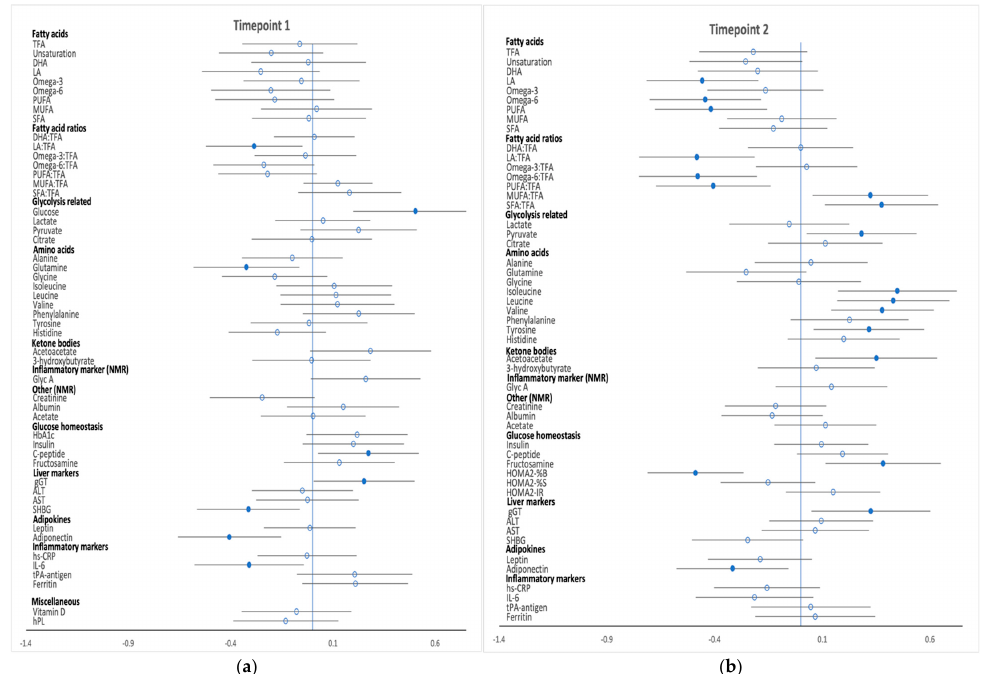
Figure 3. Differences in fatty acids, glycolysis-related metabolites, amino acids, ketone bodies and inflammatory and other markers between high-risk women who developed GDM and those who did not develop GDM at timepoints 1 ( a ) and timepoint 2 ( b ). Data points show the SD difference at baseline (timepoint 1) and at the time of OGTT (timepoint 2). Positive associations with GDM are shown to the right, negative associations are shown to the left. Closed blue circles represent FDR- corrected p values of < 0.05. DHA, docosahexaenoic acid, 22:6; LA, linoleic acid, 18:2; MUFA mono- unsaturated fatty acids, 16:1, 18:1; PUFA polyunsaturated fatty acids; SFA Saturated fatty acids; TFA, total fatty acid.